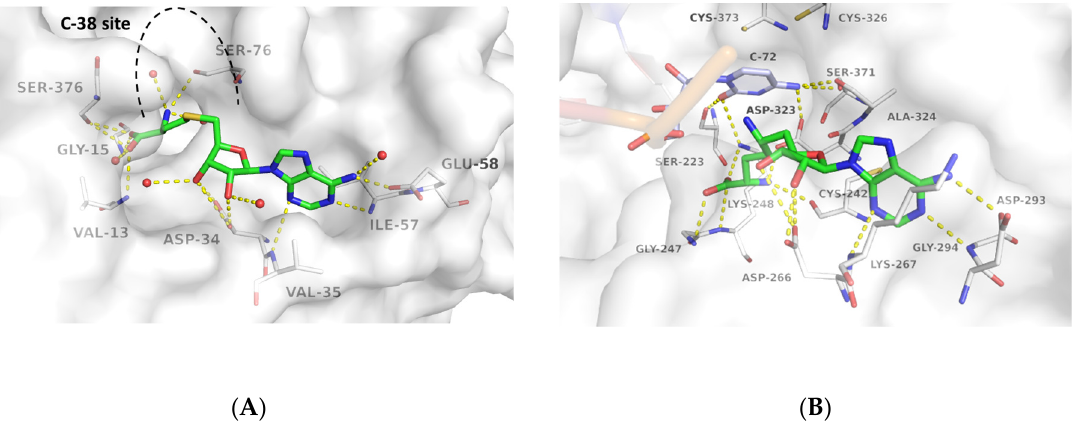
Figure 3. Binding modes of SAH-bound to DNMT2 ( A ) (PDB-ID 1G55) and SFG bound to NSUN6 ( B ) (PDB-ID 5WWR). Enzymes are shown with white surface and carbon atoms, ligands with green carbon atoms. Polar contacts are shown as yellow dashed lines, water molecules as red spheres. For clear view only residues forming polar contacts with the ligands are shown as lines and labeled as well as C-72 (light blue carbon atoms) and the catalytic Cys-residues 326 and 373 in the NSUN6-tRNA-SFG complex ( B ).